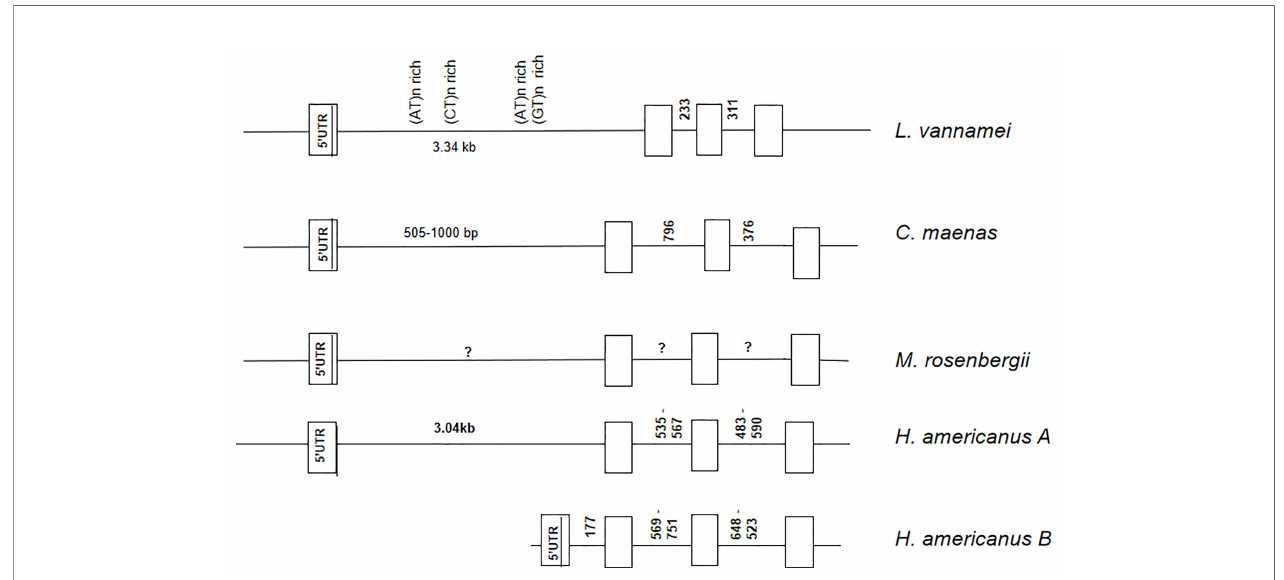
FIGURE 2 | Comparison of the four-exon CHH genes from the lobster Homarus americanus , crab Carcinus maenas , and shrimp Litopenaeus vannamei and Macrobrachium rosenbergii . Exons are indicated by the open boxes and introns are indicated by the horizontal line in between the exons. The fi rst exon consists of the 5 ′ -U ́ TR and the ATG start codon. Unknown intron sizes are indicated by an a question mark . Highly repetitive sequence (satellite DNA) clusters were identi fi ed in the promoter region of L. vannamei CHH-like gene.